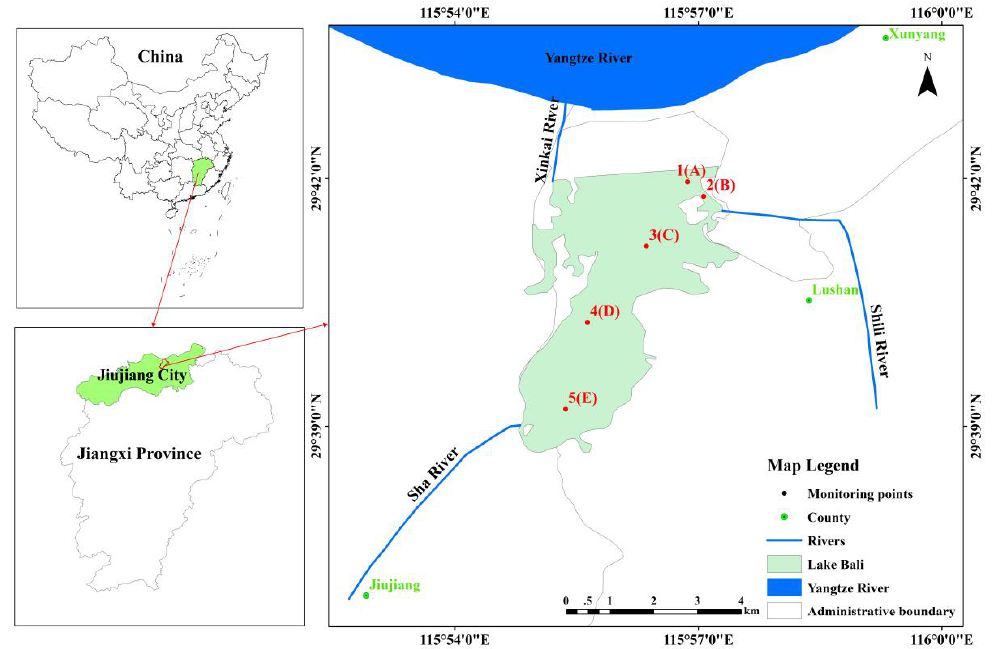
Figure 1. Monitoring point and river system outline for Lake Bali.